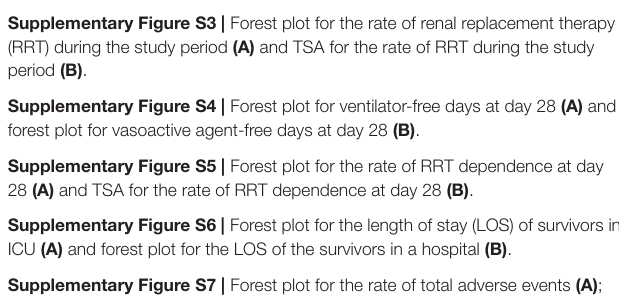
Supplementary Figure S1 | Forest plot for all-cause mortality at day 60. The size of each square represents the proportion of information provided by each study (A) ; forest plot for all-cause mortality at day 90 (B) ; forest plot for all-cause mortality in an intensive care unit (ICU) (C) ; and forest plot for all-cause mortality in a hospital (D) . Supplementary Figure S2 | Trial sequential analysis (TSA) for all-cause mortality at day 60 (A) ; TSA for all-cause mortality at day 90 (B) ; TSA for all-cause mortality in an ICU (C) ; and TSA for all-cause mortality in a hospital (D) . Supplementary Figure S3 | Forest plot for the rate of renal replacement therapy (RRT) during the study period (A) and TSA for the rate of RRT during the study period (B) . Supplementary Figure S4 | Forest plot for ventilator-free days at day 28 (A) and forest plot for vasoactive agent-free days at day 28 (B) . Supplementary Figure S5 | Forest plot for the rate of RRT dependence at day 28 (A) and TSA for the rate of RRT dependence at day 28 (B) . Supplementary Figure S6 | Forest plot for the length of stay (LOS) of survivors in ICU (A) and forest plot for the LOS of the survivors in a hospital (B) . Supplementary Figure S7 | Forest plot for the rate of total adverse events (A) ; TSA for the rate of total adverse events (B) ; forest plot for the rate of bleeding (C) ; forest plot for the rate of arrhythmia (D) ; and forest plot for the rate of hypotension (E)